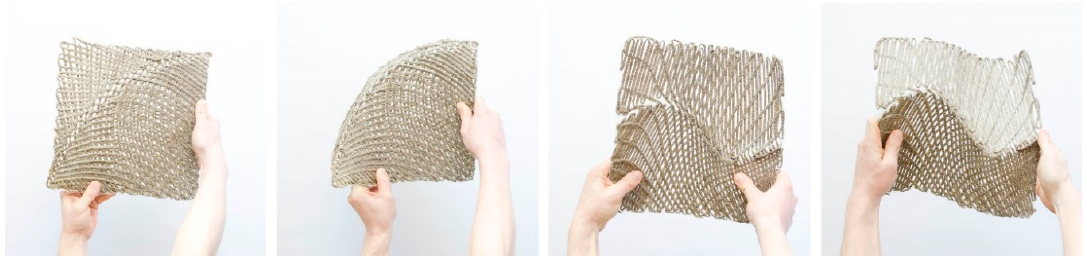
Figure 16. Sample 1 (left) and sample 2 (right) with compliant curved hinges.